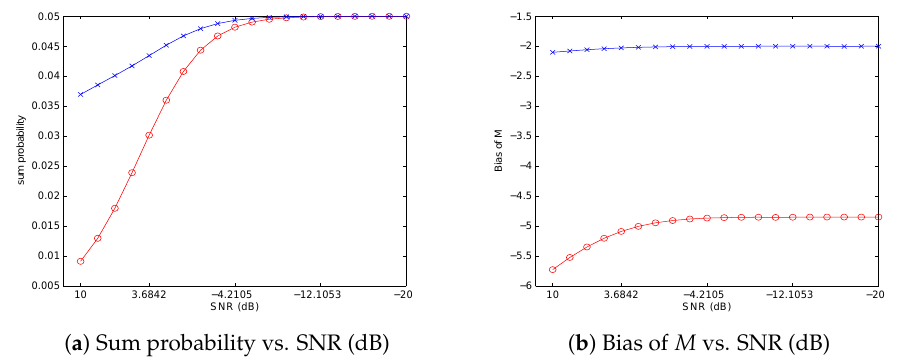
Figure 6. The plot for Example 5 under the setting SNR = 10 1 − 3 ( k − 1 ) /19 , k = 1,2, . . . ,20, corresponding to the range of 10 dB to 20 dB, α = 0.05 and σ n = 1. ( a ) The plot of the constraint summation − probabilities of (NP 1 ) and ( NP 1 ), marked by “-o” and “-x”, respectively. ( b ) The plot of the bias between the solution M from either (NP 1 ) or ( NP 1 ) and the asymptotical Equation (61), marked by “-o” (cid:102) and “-x”, respectively. (cid:102)